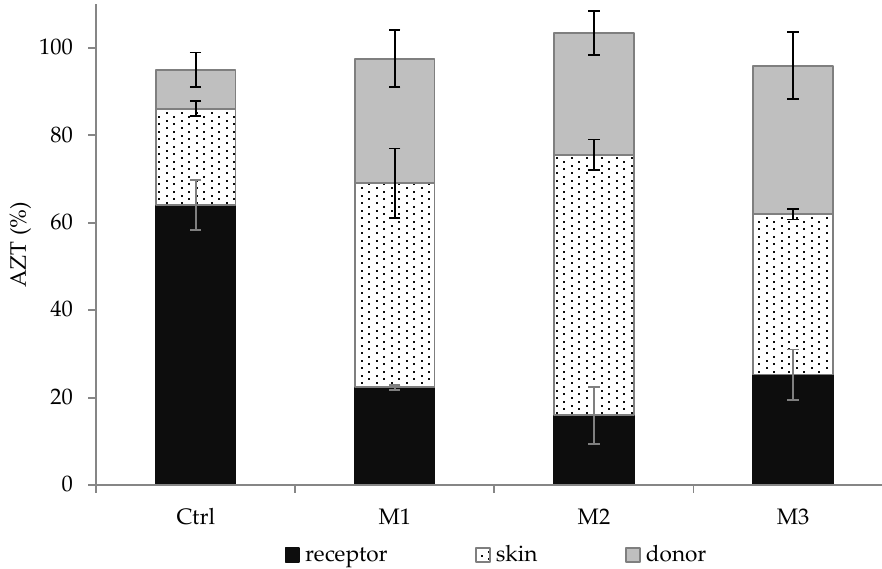
Figure 6. Percentage amount of AZT in the receptor compartment, within the skin and in the donor compartment obtained after 24 h from the application of AZT solution (control, Ctrl) or microemulsions. Data are expressed as means ± SD, n = 5.